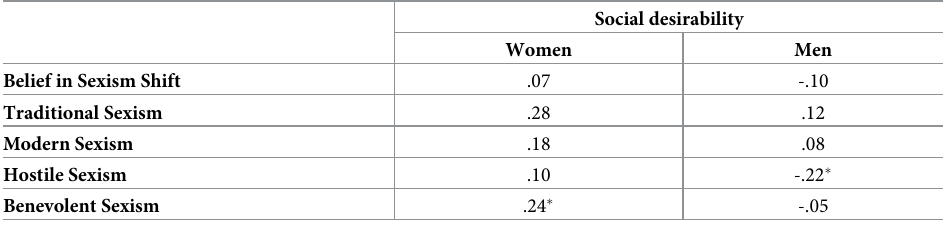
Table 7. Pearson product moment correlations of the sexism scales with social desirability by